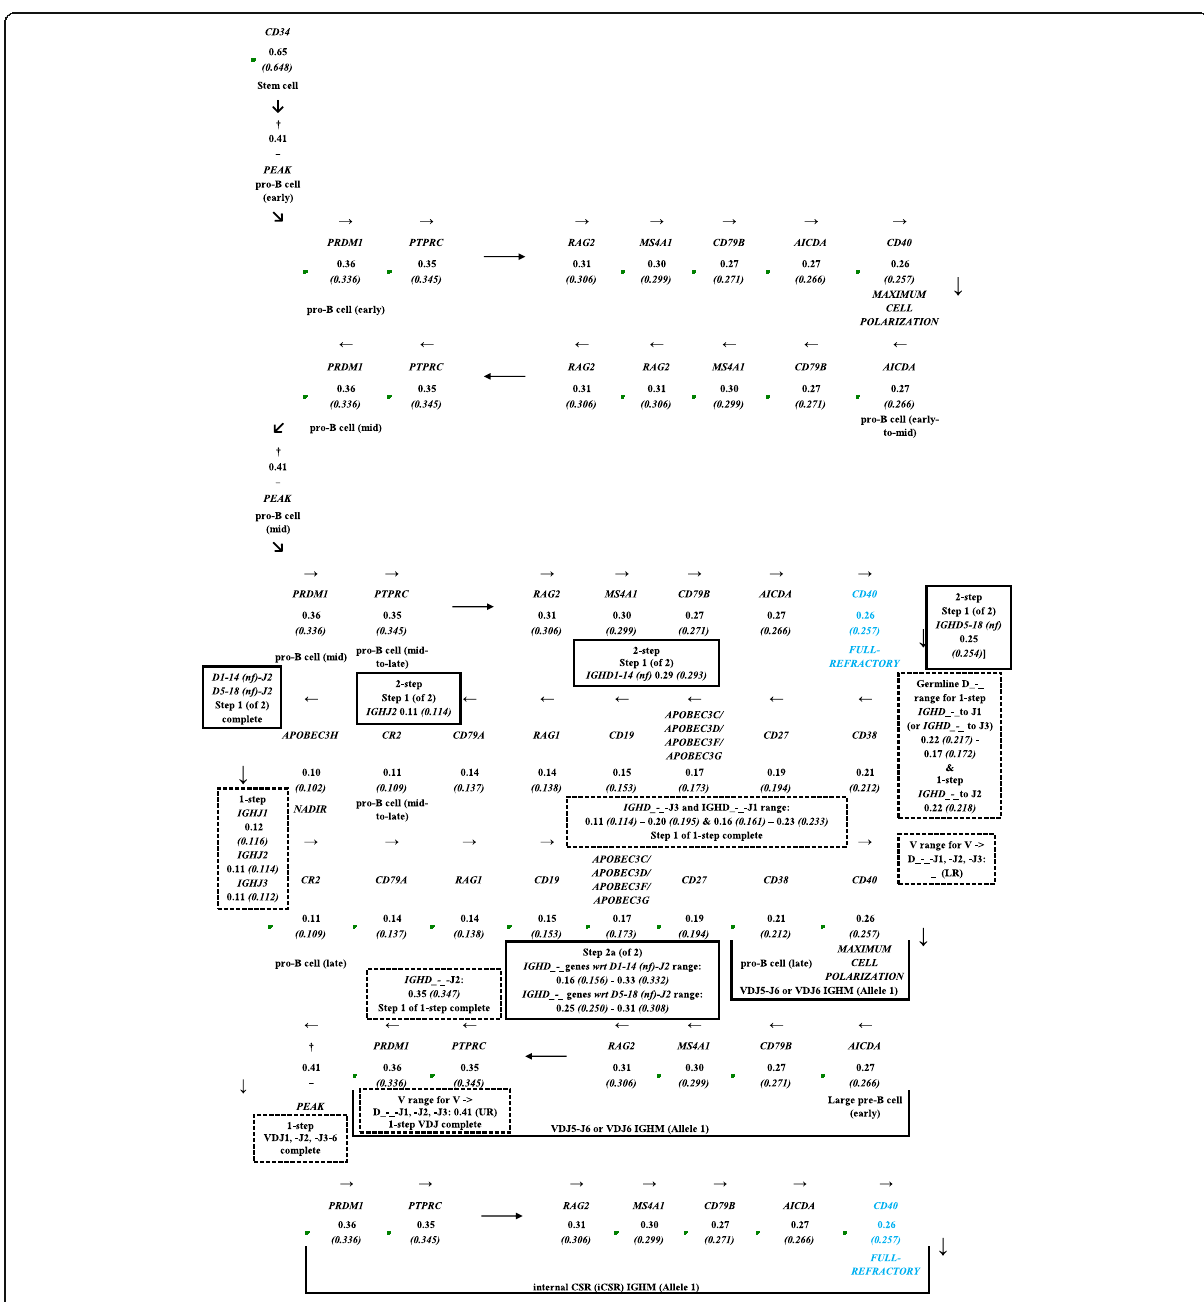
Fig. 2 Allele 2 (IGHD) 1-step and 2-step Ig heavy chain locus gene rearrangement recombination steps superimposed on the pressuromodulation map of B-cell differentiation stages. The Allele 2 one-step recombination step is IGHD_-_ and IGHJ1, IGHJ2 or IGHJ3 recombination that results in IGHD_-_ - IGHJ1 -J2 or -J3 (step 1 of 1) through the final IGHV_-_ and IGHD_-_-IGHJ1, IGHD_-_-IGHJ2 or IGHD_-_-IGHJ3 recombination that results in V_-_-DJ6 . The Allele 2 two-step recombination steps are IGHD1 – 14 (nf) or IGHD5 – 18 (nf) and IGHJ2 recombination (step 1 of 2), the IGHD_-_ genes with respect to D1 – 14 (nf)-J2 or D5 – 18 (nf)-J2 (step 2a of 2) and the IGHJ4 with respect to D1 – 14 (nf)-J2 or D5 – 18 (nf)-J2 (step 2a of 2) recombin- ation that results in IGHD_-_ - IGHJ4 (step 2b of 2) through the final IGHV_-_ and IGHD_-_-IGHJ4 recombination that results in V_-_-DJ6 . Note: Allele 2 Ig locus rearrangement recombination follows that of Allele 1 and always completes to the point of VDJ rearrangement in the marrow. In the classical pathway, homologous recombination or initial allelic exclusion followed by delayed Allele 2 iCSR (i.e. CM IgM+ IgD+) are the rule in the lymph node. In the non-classical pathway, Allele 2 locus recombination completes to the point of VDJ rearrangement (i.e CM IgM+ only). † , upper esebssiwaagoT Q units range, 0.41 – 0.36. Black, CD40 at maximum cell polarization potential. Dark blue, CD40 at half-refractory. Light blue, CD40 at full-refractory. Text boxes with complete borders, 2-step. Text boxes with dashed borders, 1-step. Large rectangular box with complete borders, extra-nodal secretory antibody